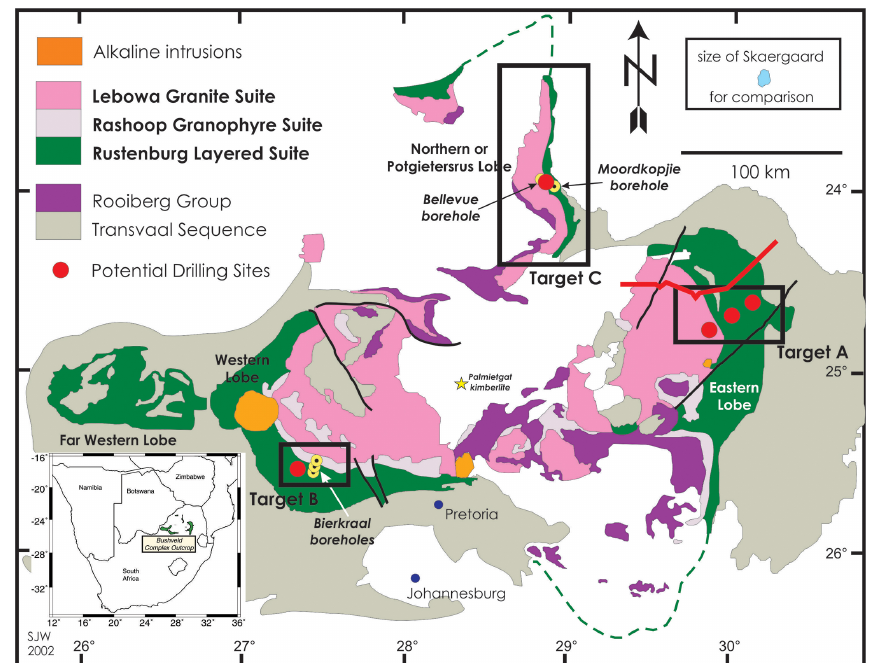
Figure 1. A simplified map of the Bushveld Complex with location of existing boreholes (yellow) and the potential ICDP sites in the western, northern and eastern lobes (red dots in boxes). The inset in upper right shows the size of the iconic Skaergaard layered intrusion for comparison. The thick red line above target A is a reflection seismic line of the Council for Geoscience. The Palmietgat kimberlite in the centre of the complex (star) contains Bushveld xenoliths, confirming geophysical evidence for a continuity of E and W lobes (see text).